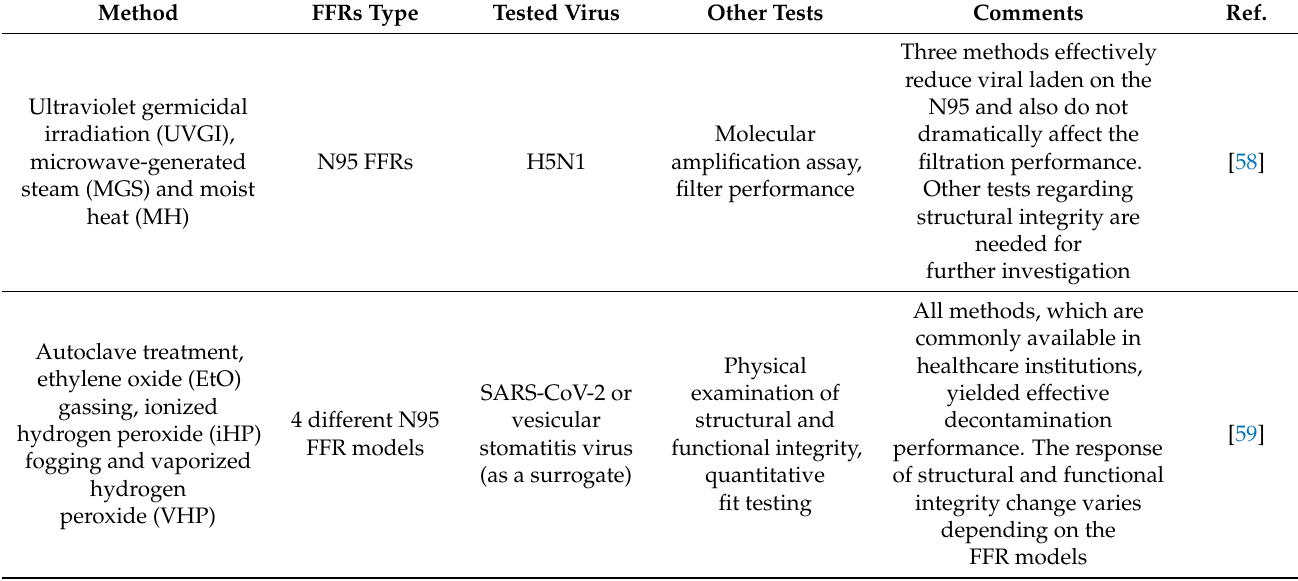
Table 1. Methods for decontamination of respirator protective devices in